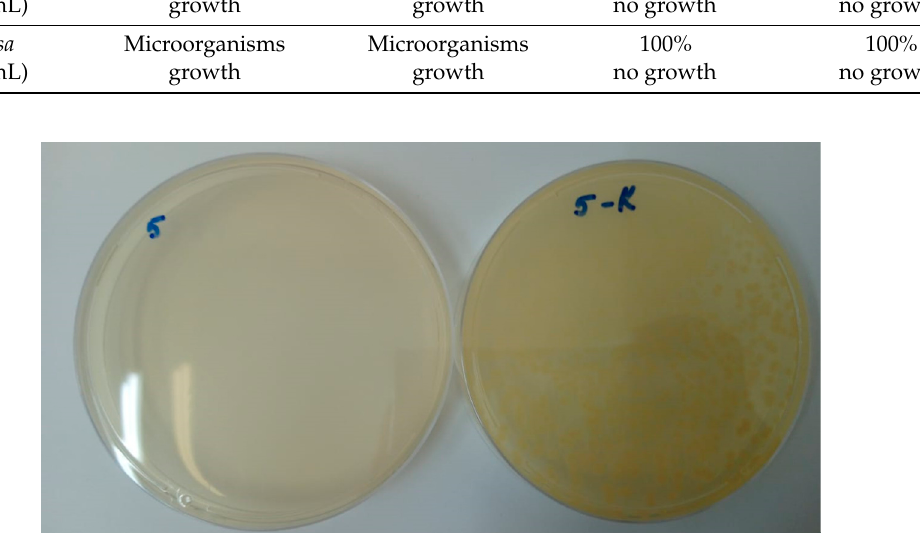
Figure 12. Culture of reference strain no. 7: Pseudomonas aeruginosa ATCC 27,853 on the sample with TiO 2 /Ag/HAp composite coating ( left ) and on a control sample ( right ).